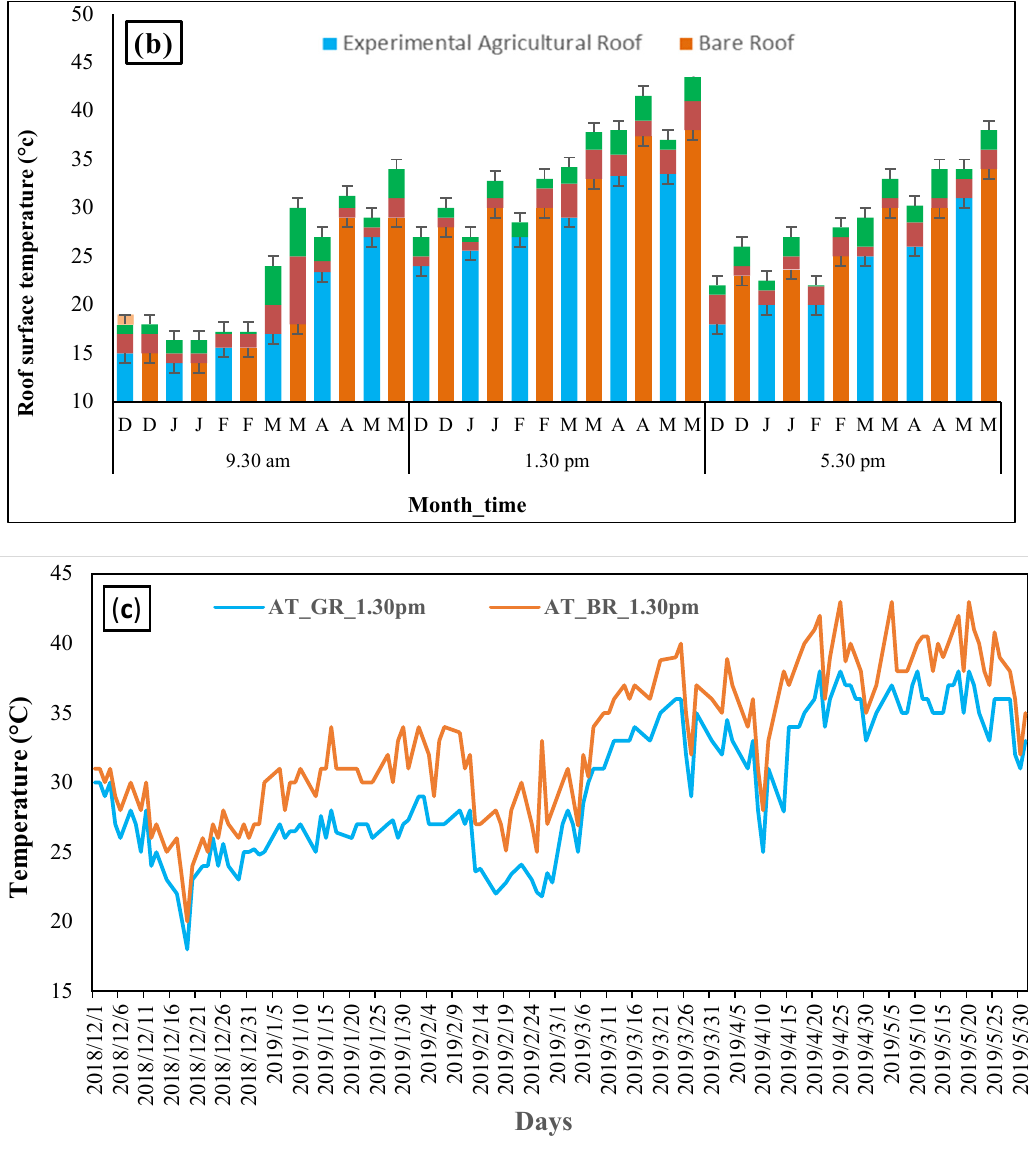
Figure 4. ( a ) Average near roof surface temperature and near land temperature variation ; ( b ) Roof surface temperature variation in experimental agricultural roof and bare roof; ( c ) Air temperature variation at 1.5 m height in agricultural roof and bare roof from December 2018 to May 2019.